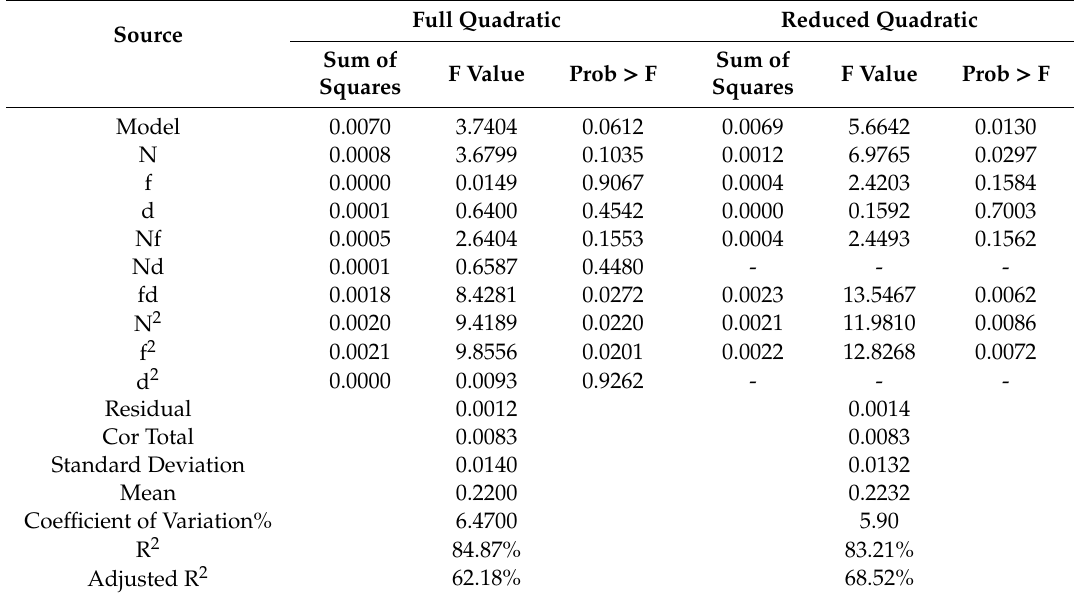
Table 4. ANOVA table for the quadratic model of